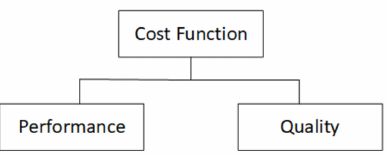
Figure 6. Cost function definition to evaluate the hot stamping